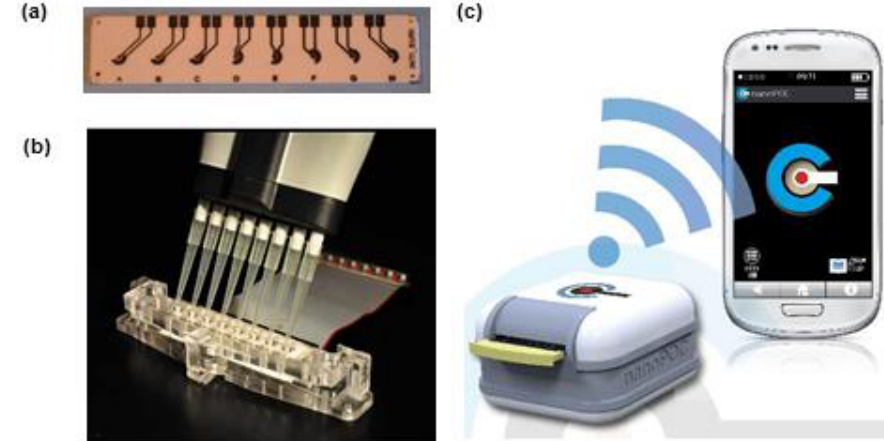
Figure 5. Analytical setup for casein detection including screen-printed electrodes ( a ), set of 8 electrochemical cells ( b ) and portable potentiostat controlled by smartphone via Bluetooth ( c